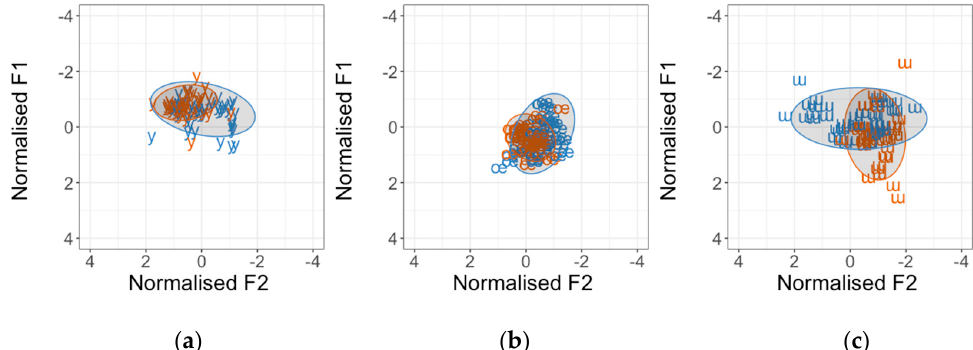
Figure 6. ( a ) Urban (blue) versus regional (orange) groups’ productions of the vowel /y/. ( b ) Urban (blue) versus regional (orange) groups’ productions of the vowel /œ /. ( c ) Urban (blue) versus regional (orange) groups’ productions of the vowel / ɯ /.